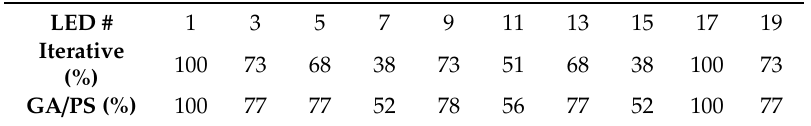
Comparison between the iterative optimization method, described in Section 2.2, and, as reference, the Genetic Algorithm (GA) and Pattern Search (PS)-based methods in MATLAB. The values are normalized to their respective